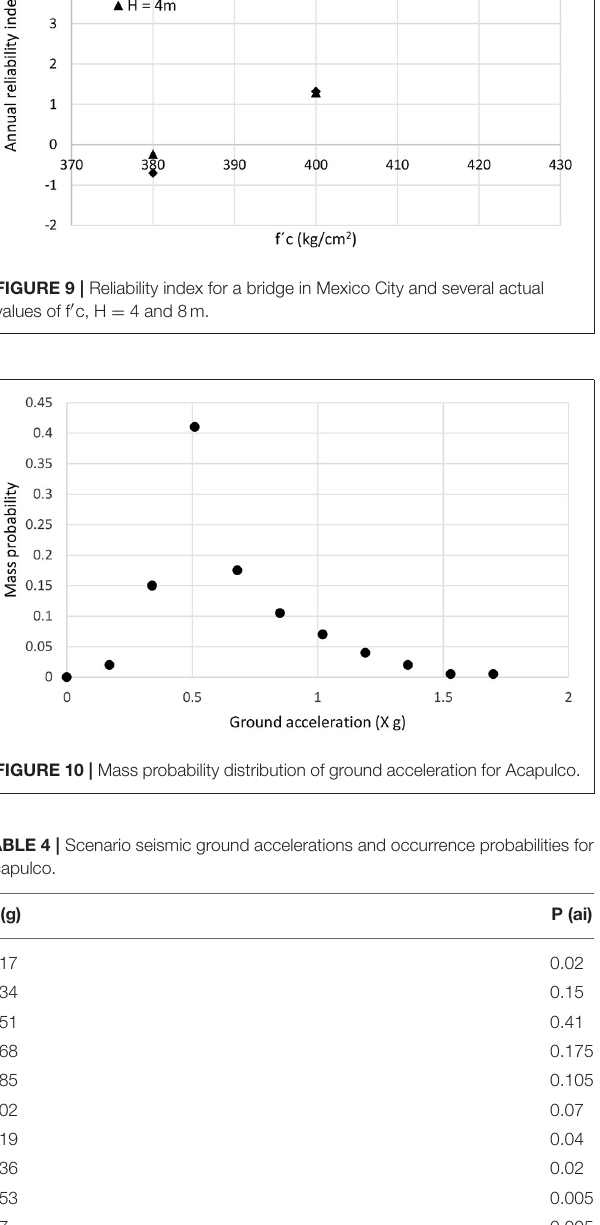
Given the stronger seismic demands in Oaxaca, the piers design shall consider larger diameters and larger number and size of rebars. See Table 7 for the initial costs for scenario ground